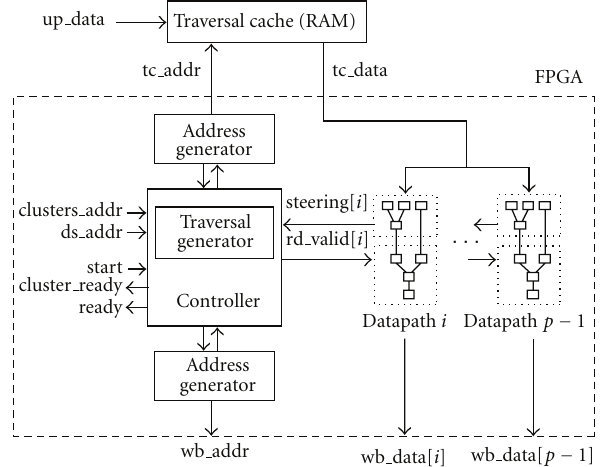
Figure 4: FPGA portion of the extended traversal cache framework with unrolled datapaths, each provided with separate traversals through selectively enabled rd valid[i] signals. Element member- ship in each traversal is determined by application-specific logic, generator kernels , as part of each datapath (shown here as a dotted segment) and typically data structure-specific logic in the traversal generator , shown here as part of the